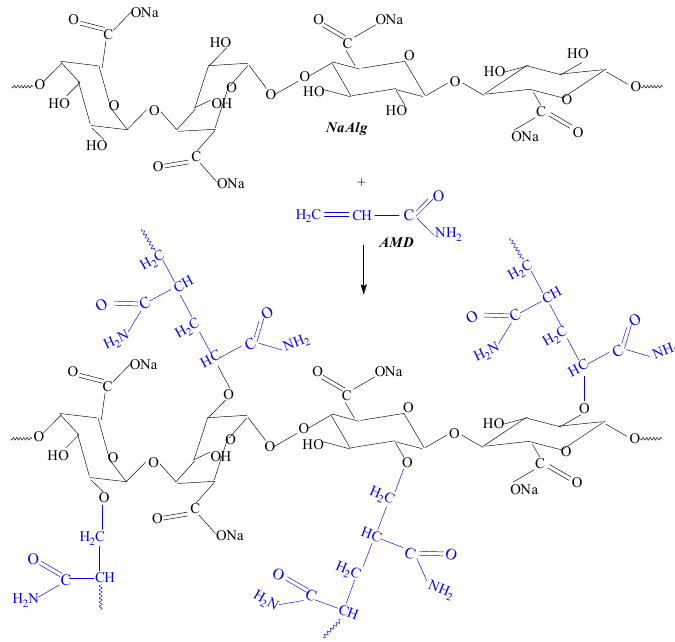
Figure 8. Possible mechanism of acrylamide grafting on sodium alginate backbone.